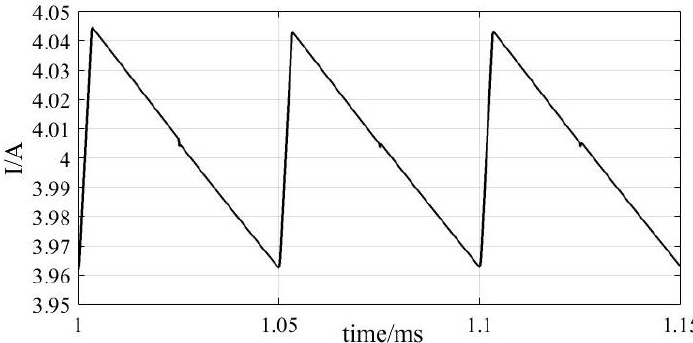
Figure 12. Current control loop with a three-phase-half-bridge SPA.